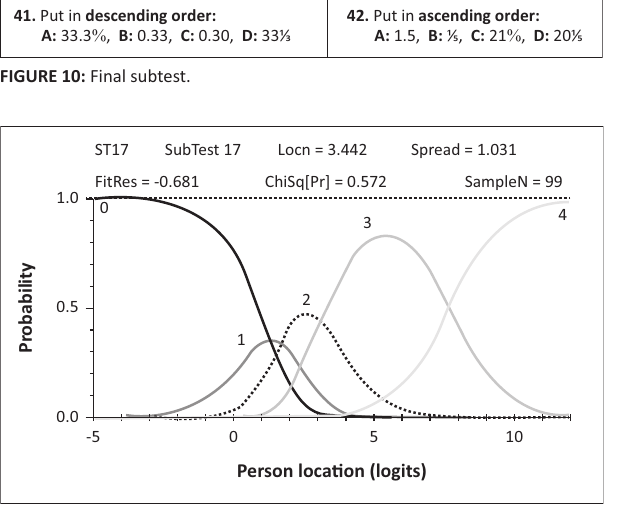
FIGURE 11: Subtest 17 (questions 39–42) – re-scored category probability